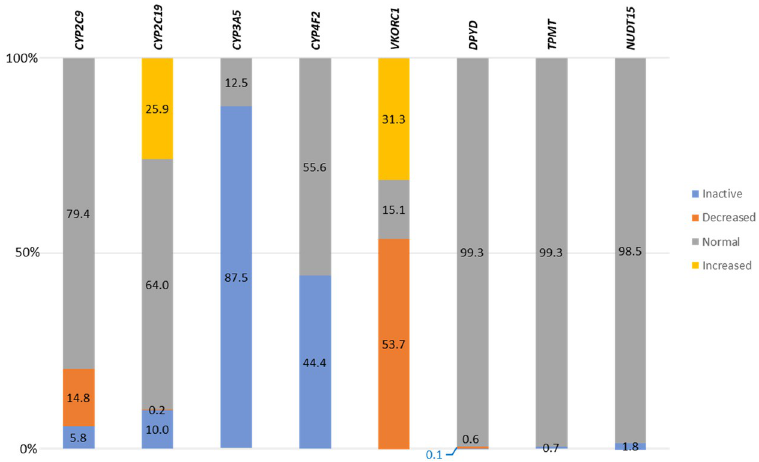
Fig 1. Combined functional consequences of genetic variations in pharmacogenes, within the Saudi population.